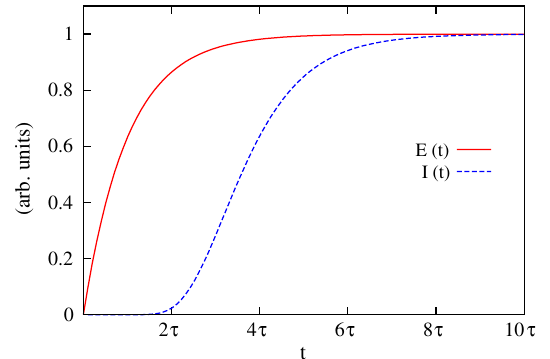
FIG. 5. Cavity wall and longitudinal field distribution of a 1.25 cells